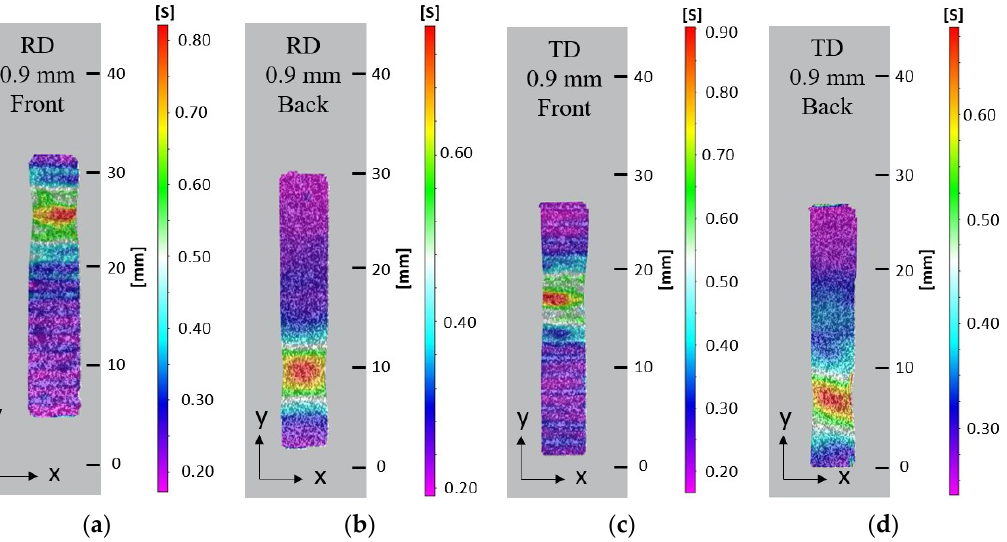
Figure 15. Effective surface strain at 90% extension on the LMD (front) surface and the reverse (back) side with no LMD: ( a ) Front of RD 0.9mm LMD sample; ( b ) Back of RD 0.9 mm LMD sample; ( c ) Front of TD 0.9 mm LMD sample; ( d ) Back of TD 0.9 mm LMD sample.